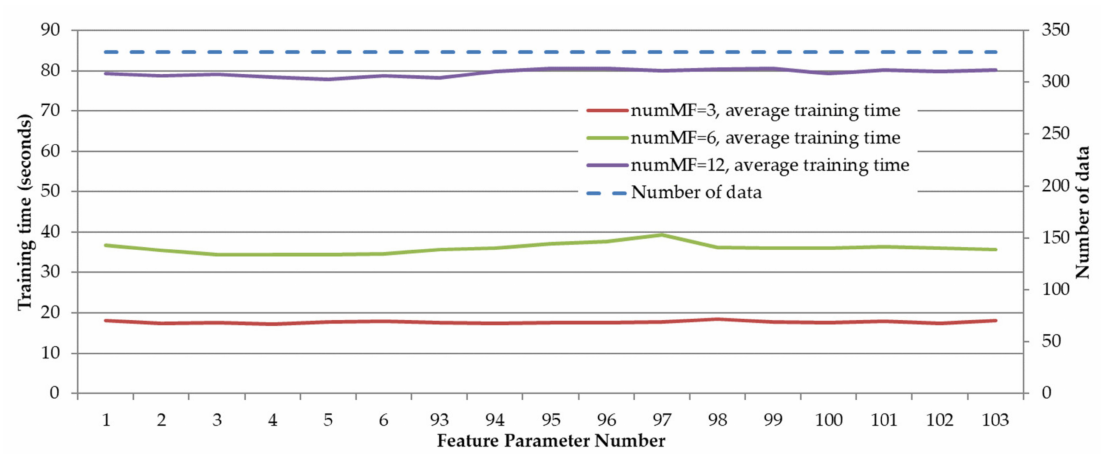
Figure 23. Average training error for different MFs.